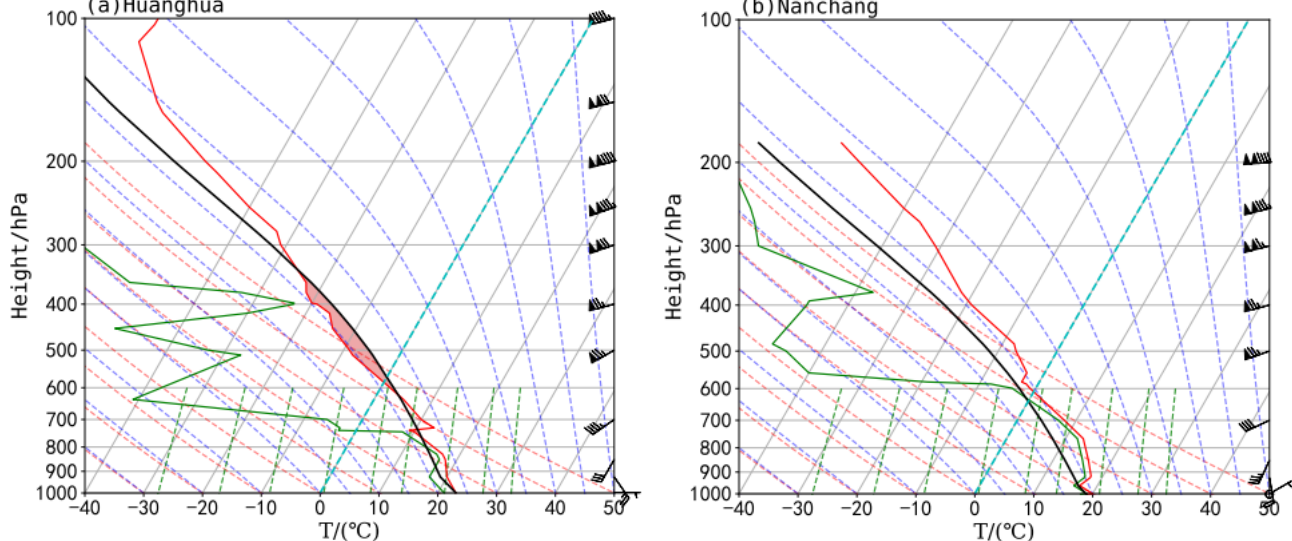
Figure 3. T -ln P chart at Huanghua ( a ) and Nanchang ( b ) radiosonde station at 1200 UTC on 15 April 2016 (the green line represents dewpoint profile, the black line represents the lifting curve, the red line represents temperature profile).